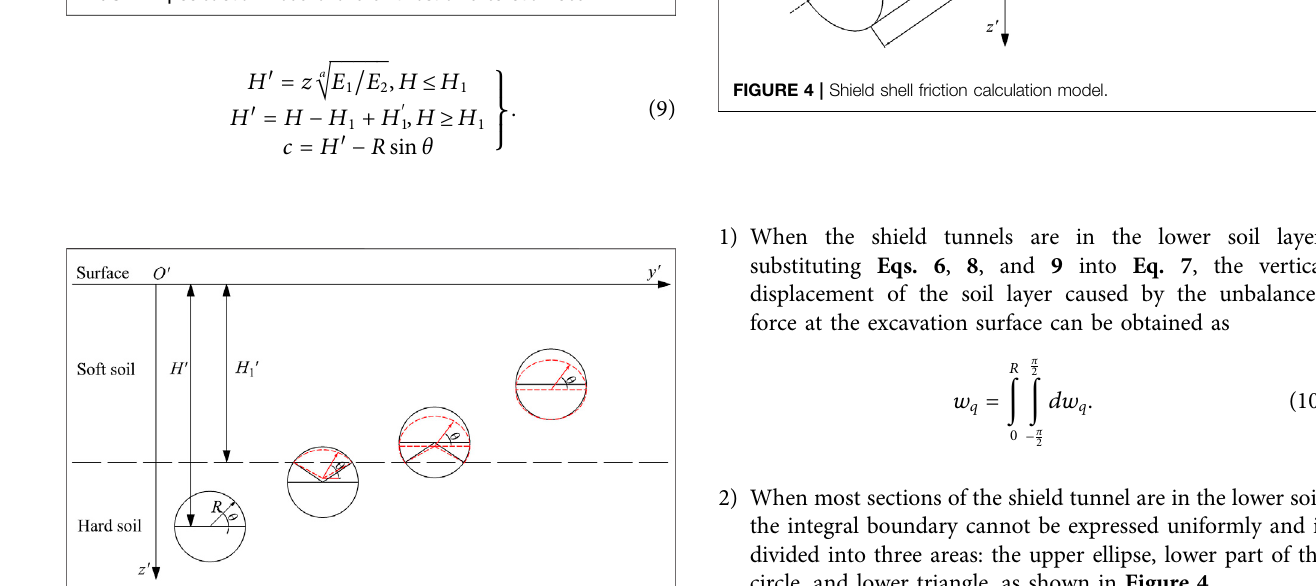
FIGURE 2 | Calculation model of uneven thrust on excavation face.